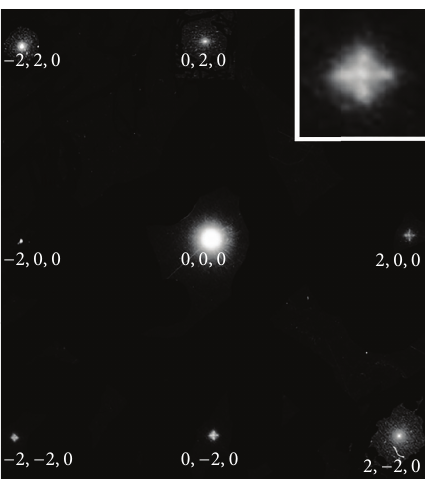
Figure 7: An example of low angle electron diffraction of Cu- 1.8at%Fe-1.2at%Co.